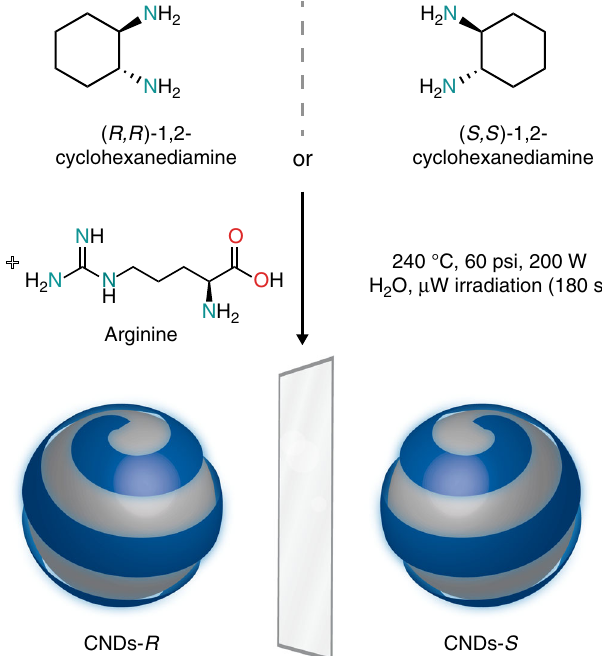
Fig. 1 Design and synthesis of chiral carbon nanodots. Chiral CNDs were synthesized starting from ( R , R )- or ( S , S )-1,2-cyclohexanediamine and arginine, under hydrothermal microwave-assisted conditions (240 °C, 70 – 110 psi, 200 W for 180